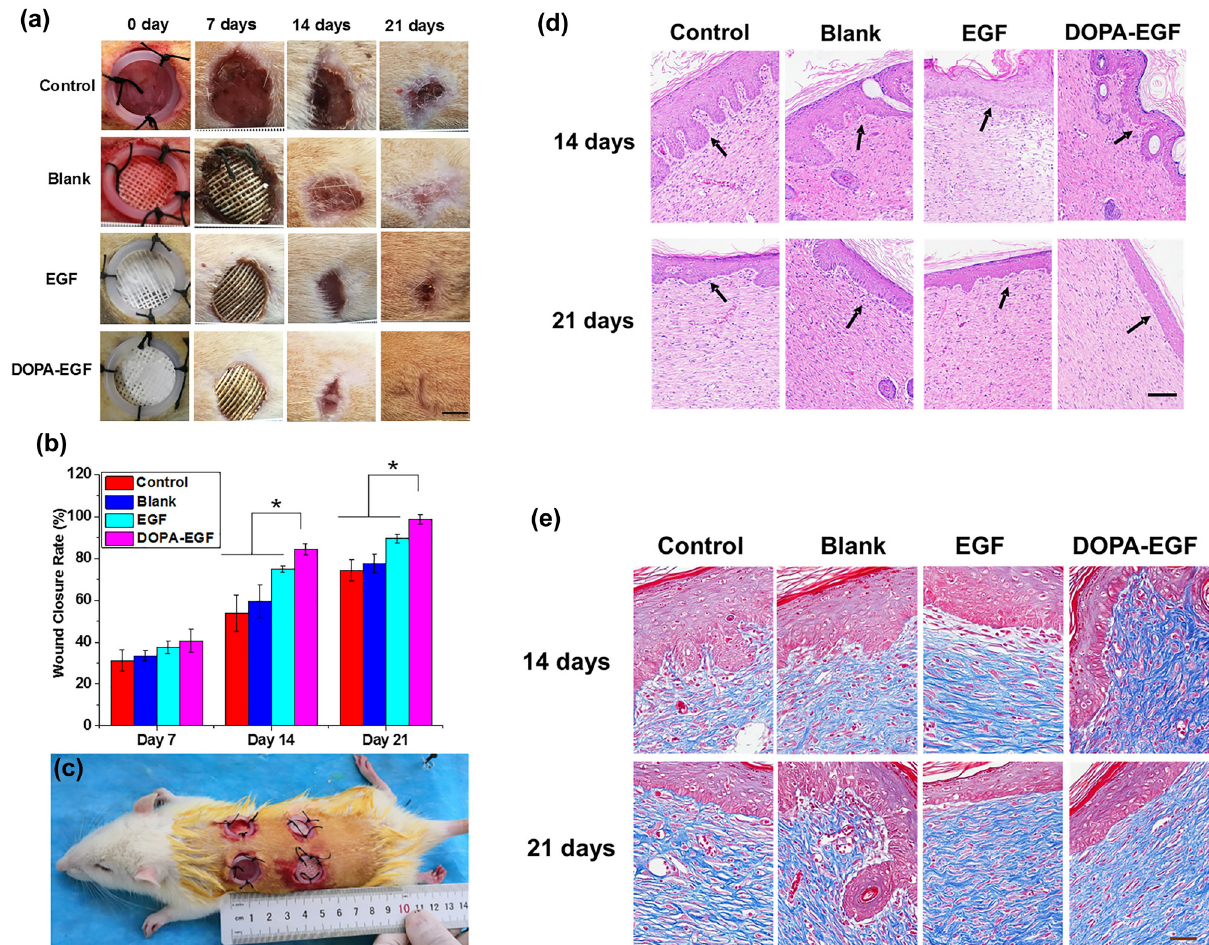
Figure 4: ( a ) Images of wound closure for control group, blank group, EGF group, and DOPA group at day 7, 14, and 21. ( b ) Wound closure rate for control group, blank group, EGF group, and DOPA group at day 7, 14, and 21. ( c ) Image of the excisional wound model ( scale bar is 5 mm ) . ( d ) Images of H&E staining for di ff erent groups at day 14 and 21 ( magni fi cation is 200 × , scale bar is 100 µm ) . ( e ) Masson ’ s trichrome staining for di ff erent groups at day 14 and 21 ( magni fi cation is 400 × , scale bar is 50 µm ) . Reproduced with permission from Gao et al. [ 92 ]